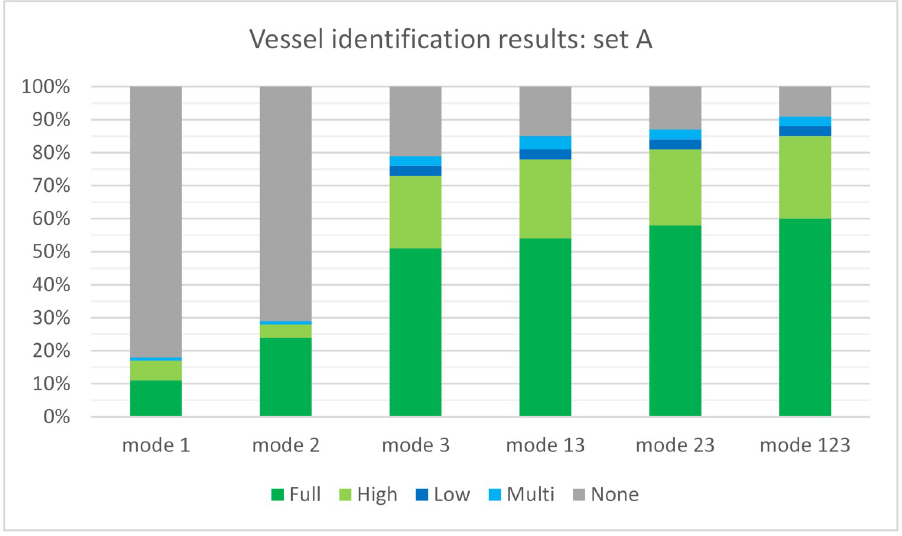
Fig 7. Identification quality for dataset